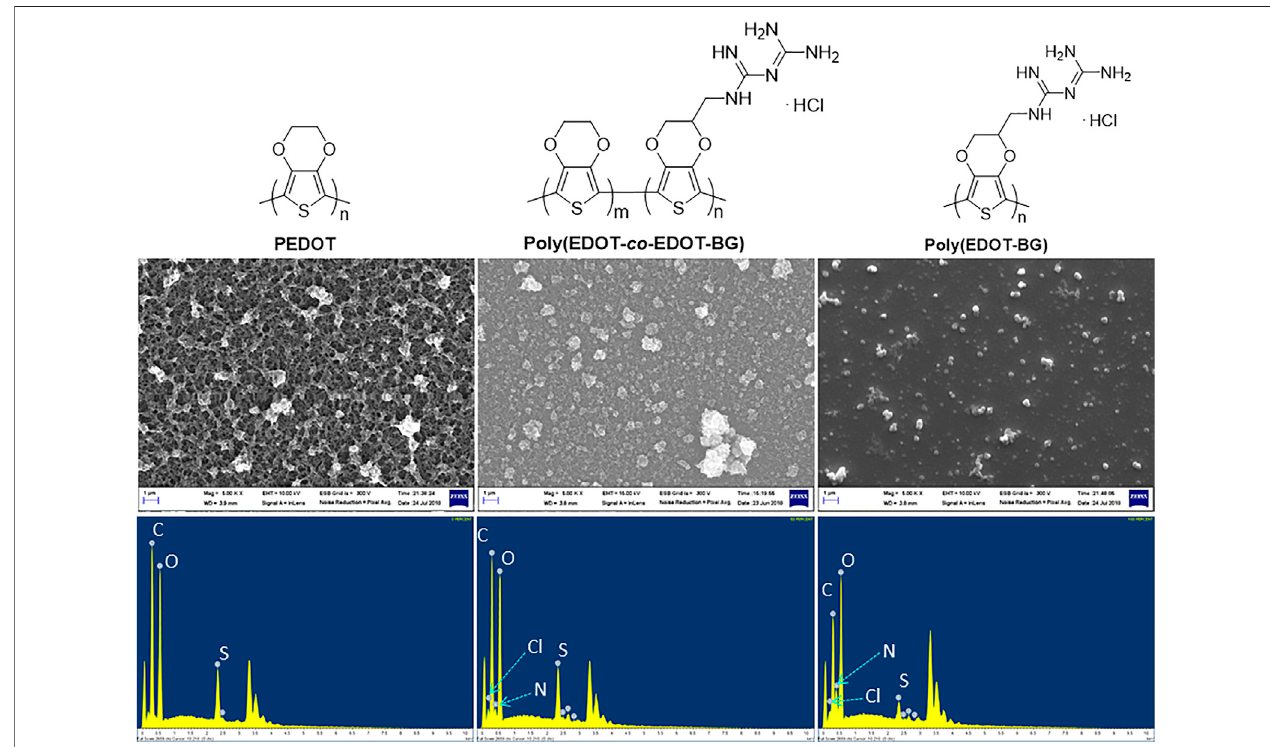
FIGURE 3 | SEM images (upper) and EDX elemental mapping (lower) of PEDOT, poly(EDOT- co -EDOT-BG), and poly(EDOT-BG) polymers electrodeposited on ITO-glass slides.